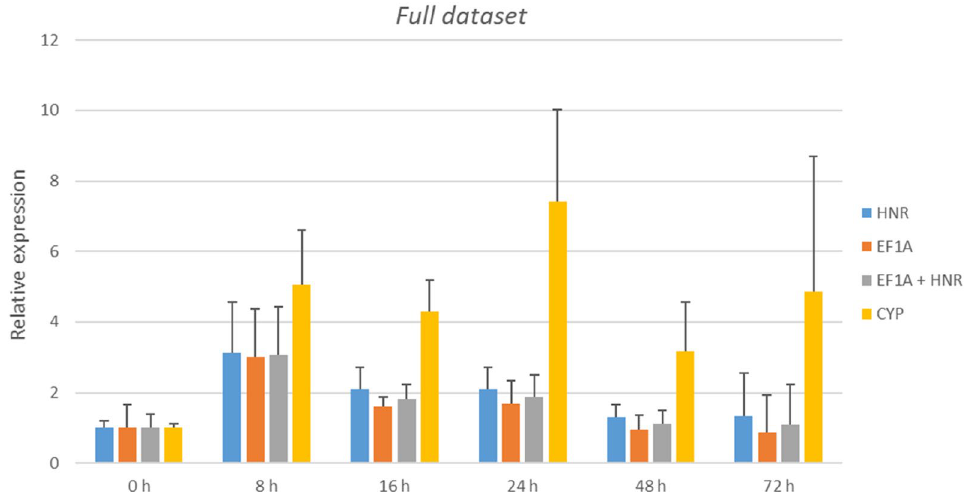
Figure 7. Relative expression of the PAL gene following P. coronata f. sp. avenae inoclulation. Analysis was performed for full dataset normalized against two best performing RGs ( HNR and EF1A ) separately or together as well as against worst performing RG ( CYP ). Data is shown as mean ±